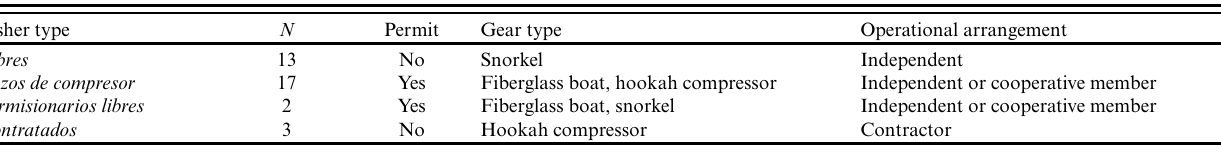
Table 2. Types of fishers associated with the Mexican chocolate clam fishery in Loreto Bay National Park, Baja California Sur, Mexico. Typologies are based on permit status, primary gear type, and type of operational